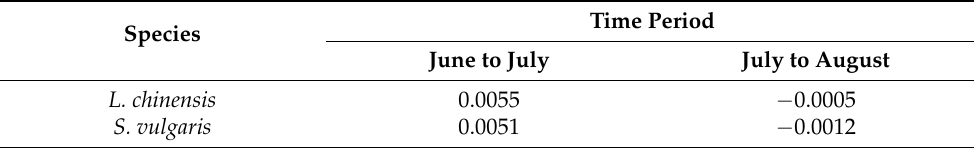
Table 5. Relative growth